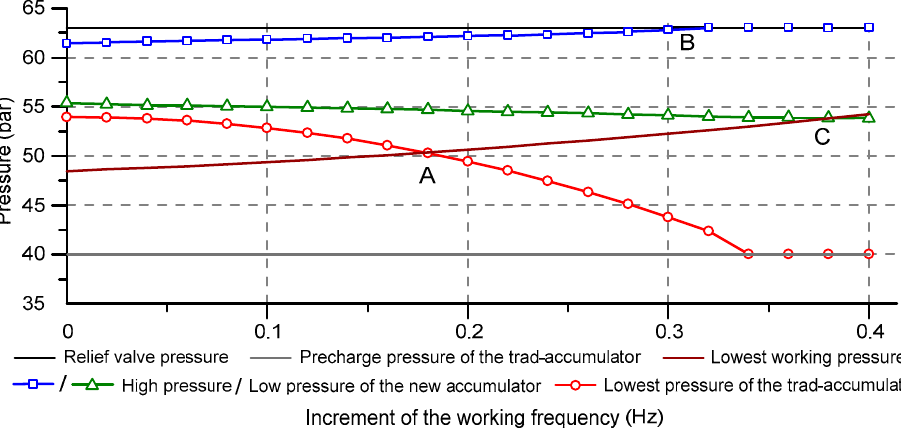
Figure 12. Pressure variations of the two accumulators with different increment of the working frequency.